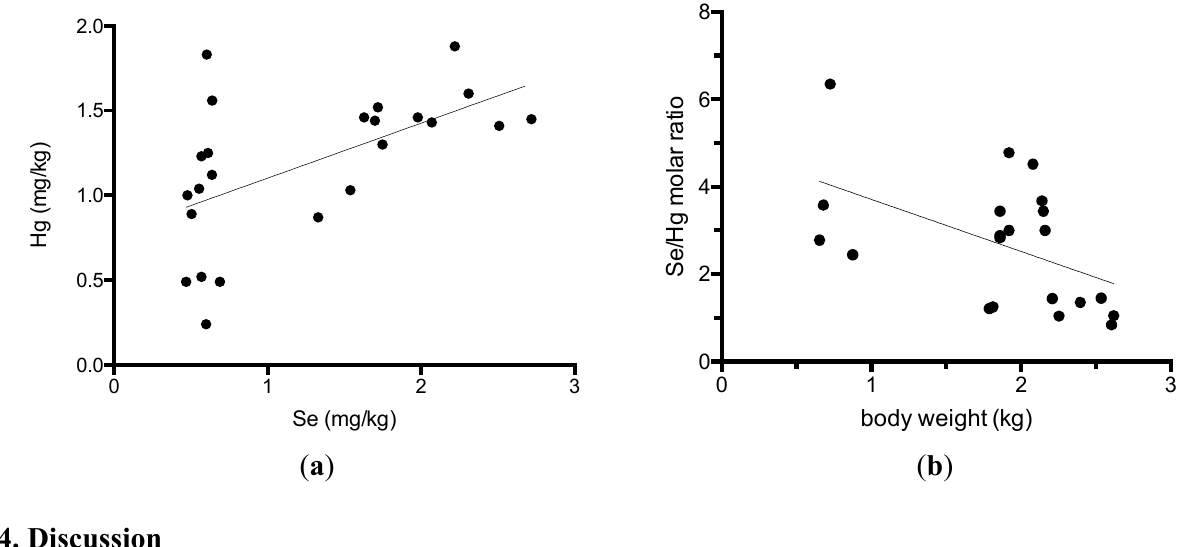
Figure 1. Relationship between the selenium and mercury content in the white and red muscles of alfonsino ( Beryx splendens ). ( a ) Relationship between the selenium and mercury contents; ( b ) Relationship between the body weight and Se/Hg molar